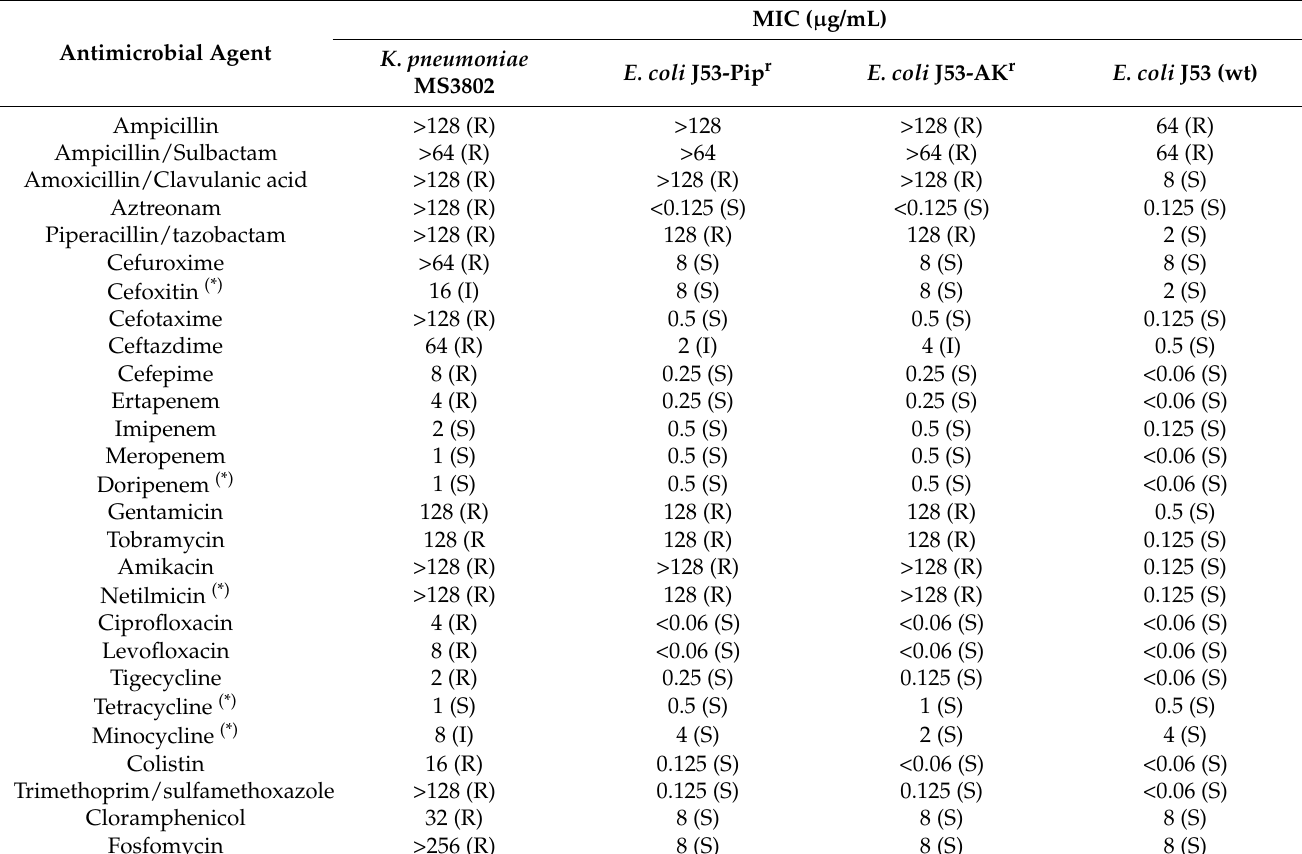
Table 1. Antimicrobial susceptibility profiles of the Klebsiella pneumoniae isolate MS3802 and Escherichia coli J53 transconju- gants with the plasmid